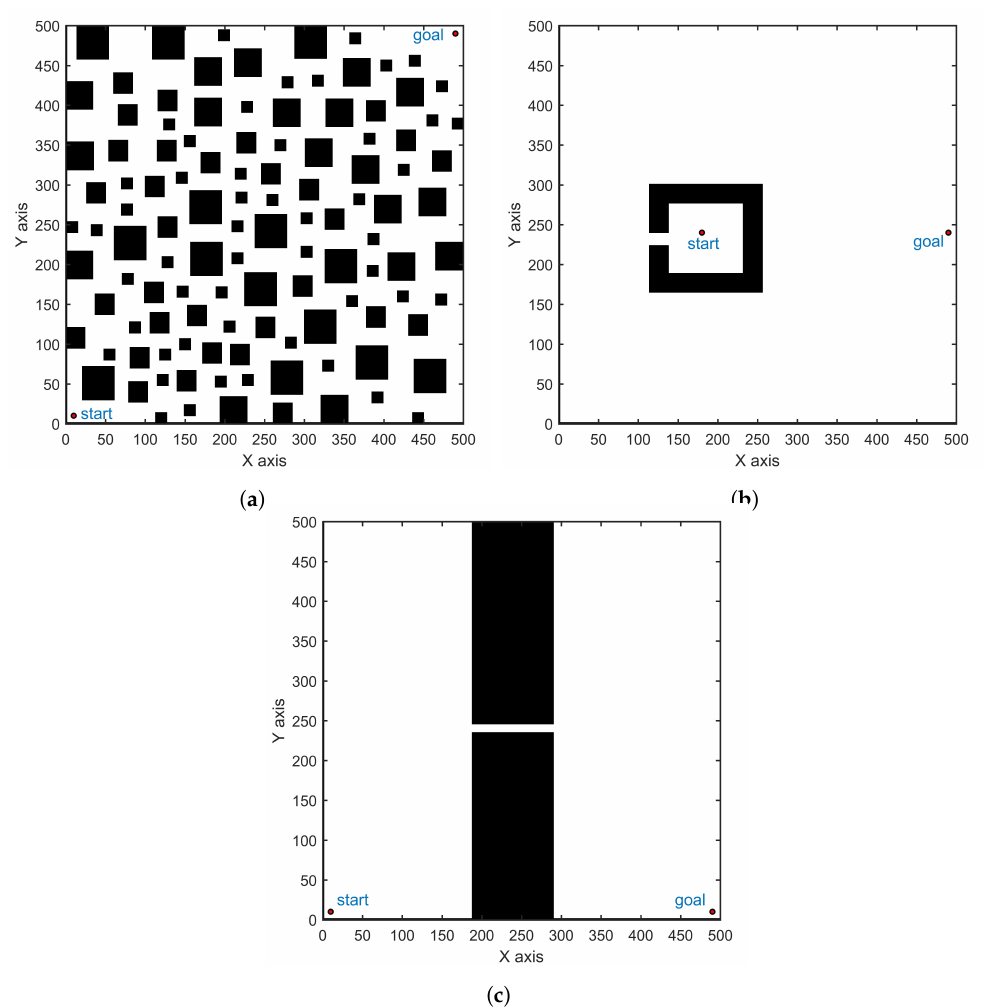
Figure 4. Three typical environments in a two-dimensional space. ( a ) The cluttered environment. ( b ) The trapped environment. ( c ) The narrow